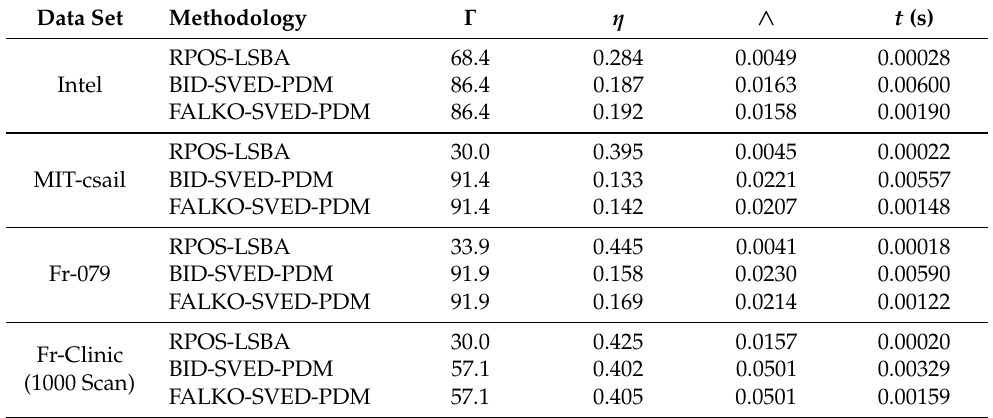
Table 1. B-spline features assessement. Data Set